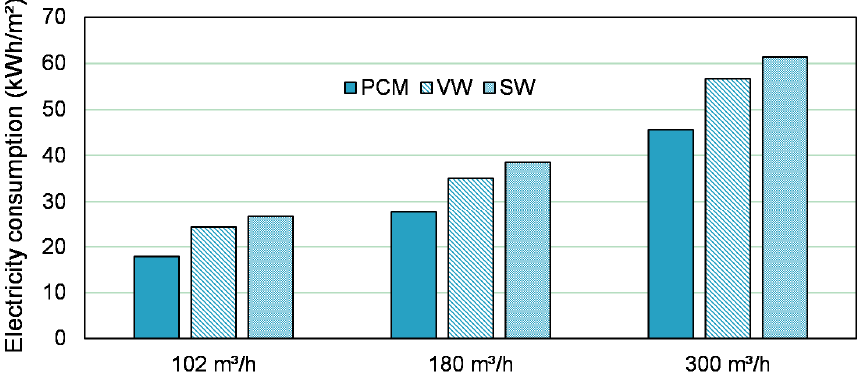
Figure 21. The winter total electricity consumption of the house (six-month period) under different ventilation flow rates.